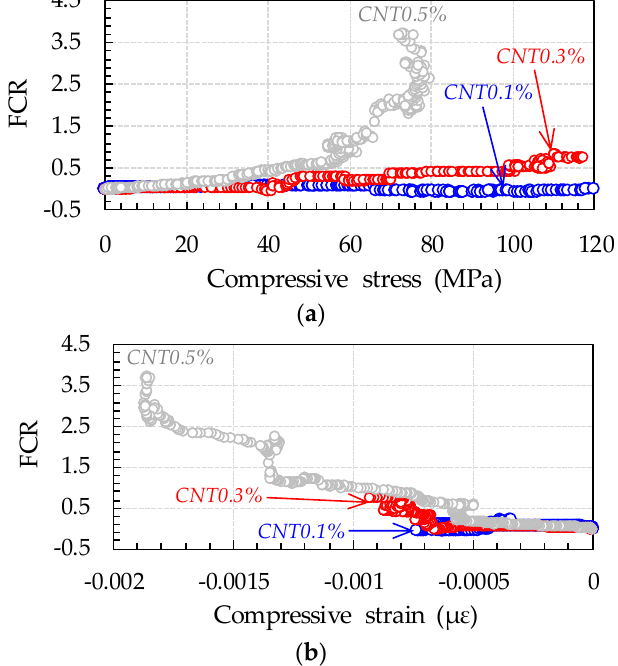
Figure 13. Comparative FCR and: ( a ) compressive stress; and ( b ) compressive strain curves of UHPFRCs with various amounts of CNTs.